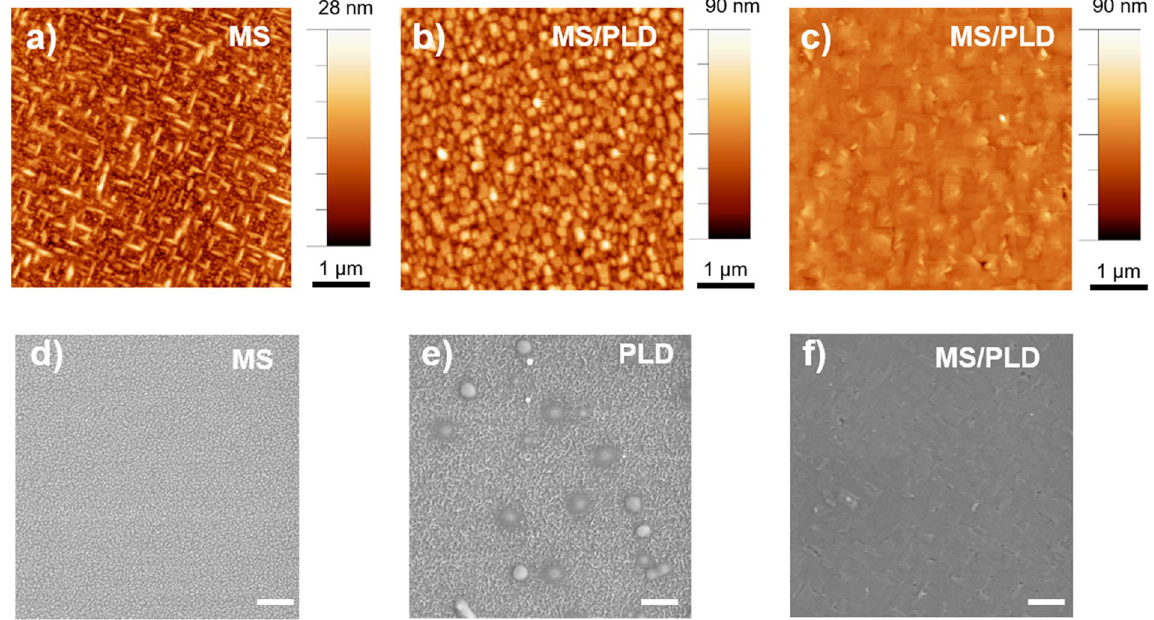
Figure 7. AFM images on an area of 5 μ m × 5 μ m of different BFCO thin film samples: ( a ) BFCO on LAO(100) deposited with MS at 750 °C, ( b ) BFCO on LAO(100) deposited with MS/PLD at 650 °C, ( c ) BFCO on LAO(100) deposited with MS/PLD at 750 °C. SEM images of films prepared by sputtering, PLD and by hybrid technique: ( d ) MS deposition of BFCO on Si(100), ( e ) PLD deposition of BFCO on Si(100), ( f ) MS/PLD deposition on LAO (100) at 750 °C. The scale bar is 1 μ